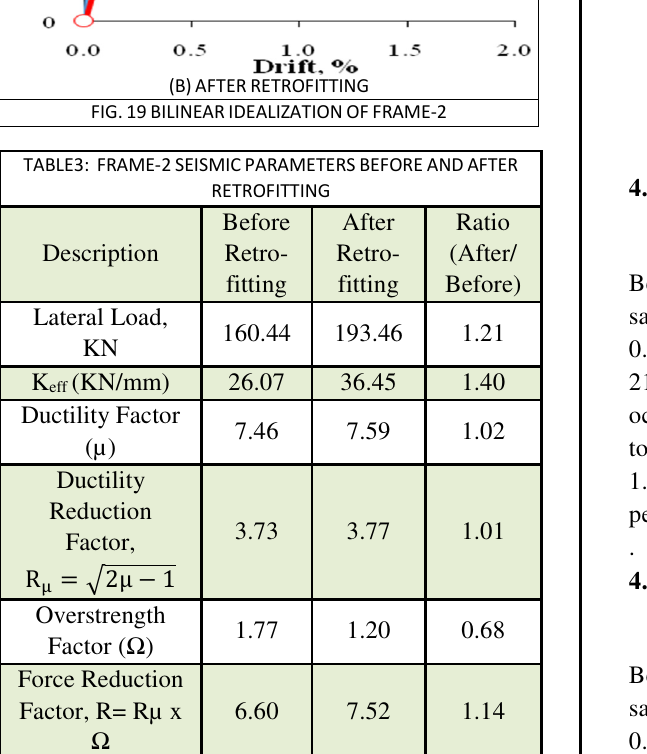
FIG. 20: PERFORMANCE LEVELS (ASCE/SEI 41-06)